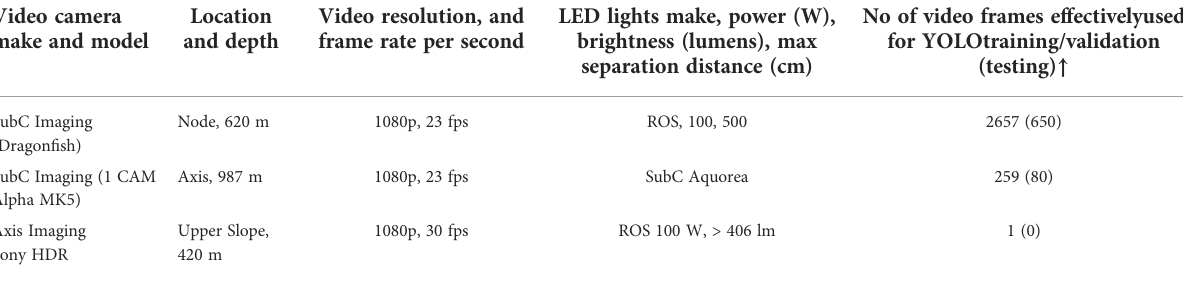
TABLE 1 Camera speci fi cations and deployment details according to the locations shown in Figure 1 . Video camera make and